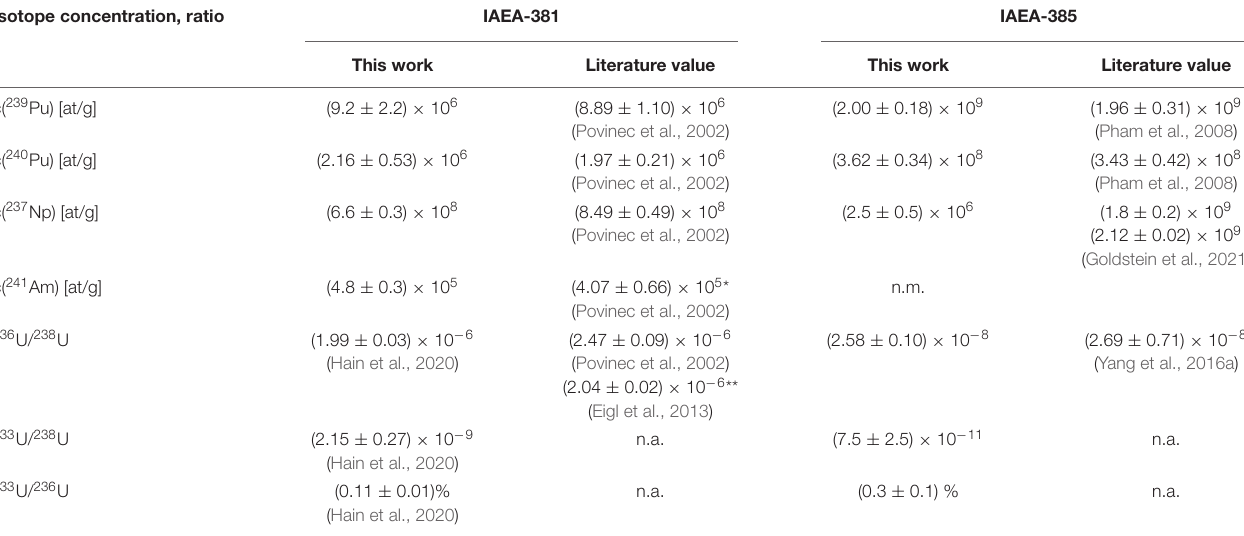
TABLE 2 | Comparison of results obtained by the VERA routine analysis of long-lived actinides in reference materials with literature values. Isotope concentration,